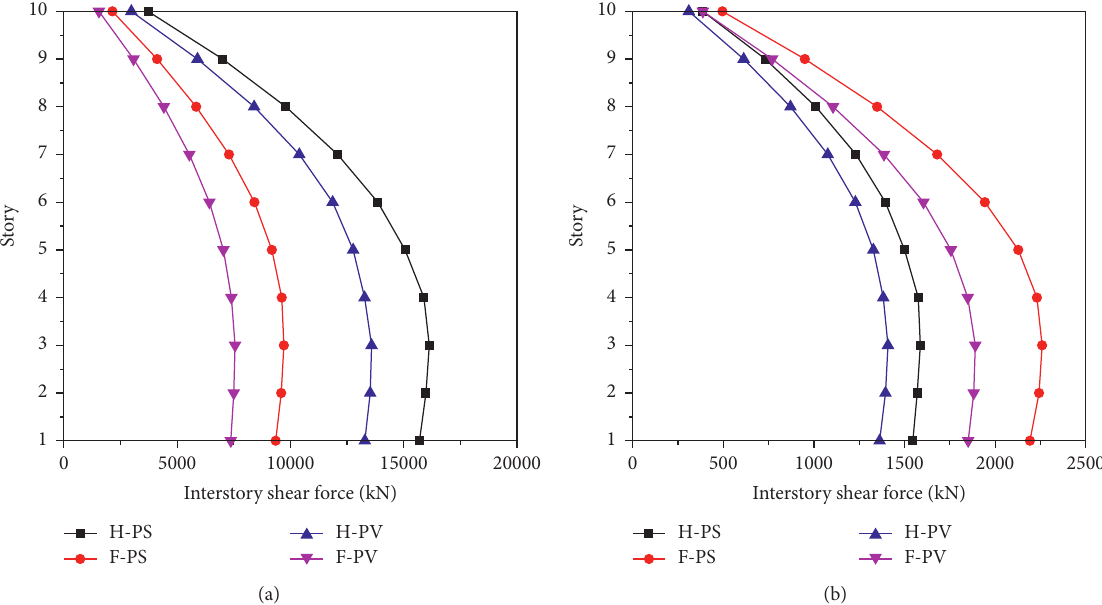
Figure 9: The average peak interstory shear force of the structure under the hanging wall and footwall seismic excitations: (a) without amplitude modulation; (b) with amplitude modulation.